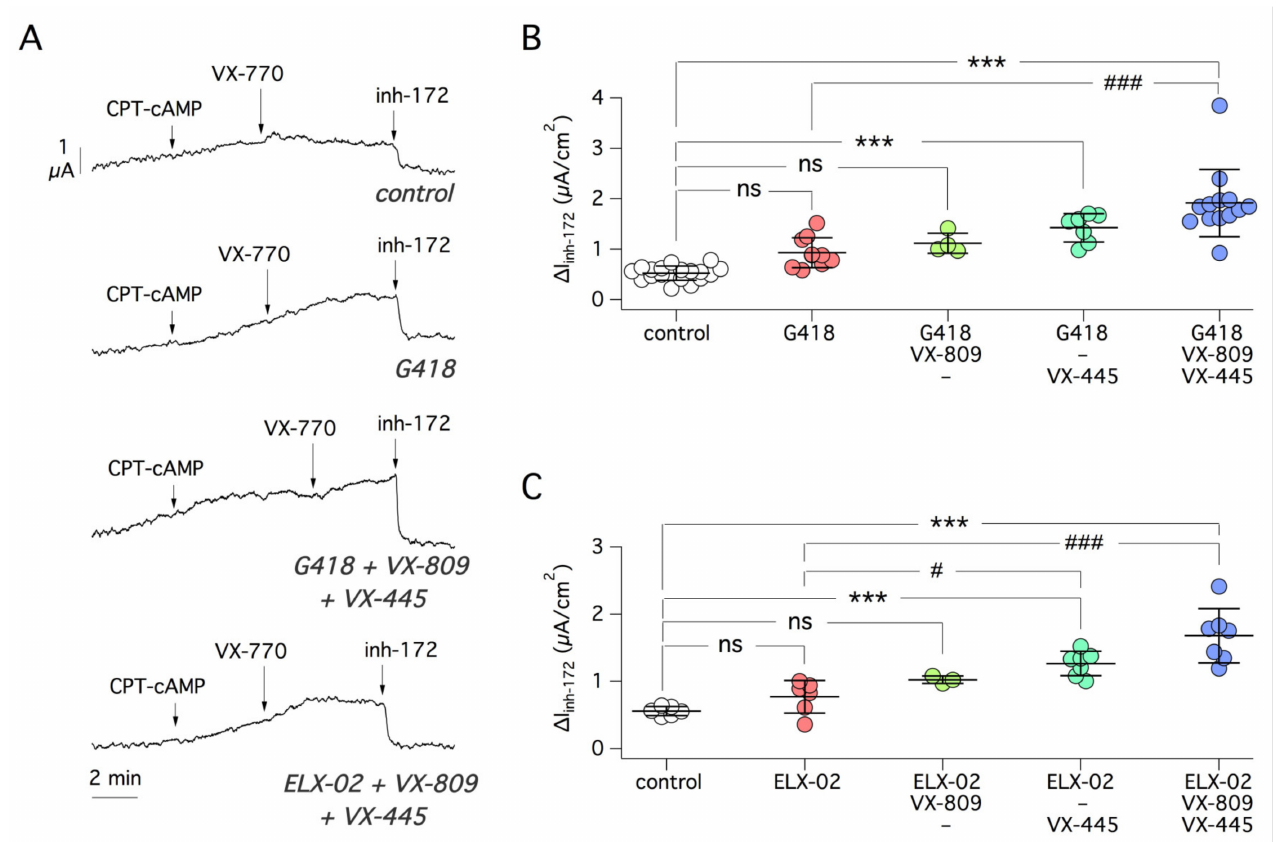
Figure 6. Evaluation of readthrough agents on W1282X-CFTR. ( A ) Representative short-circuit current traces from 16HBE14o- cells expressing W1282X-CFTR, treated for 24 h with the indicated compounds. ( B , C ) Summary of data reporting CFTR function (amplitude of inh-172 effect). Cells were treated with G418 0.5 mg/mL or ELX-02 0.5 mg/mL, alone or in combination with CFTR correctors VX-809 (1 µ M) and/or VX-445 (5 µ M). ***, p < 0.001 vs. control. #, p < 0.05; ###, p < 0.001 vs. G418 or